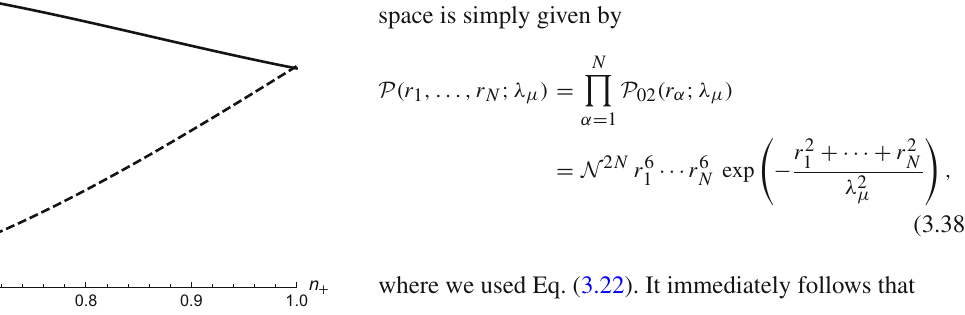
(cid:6) ( dashed line ) in H